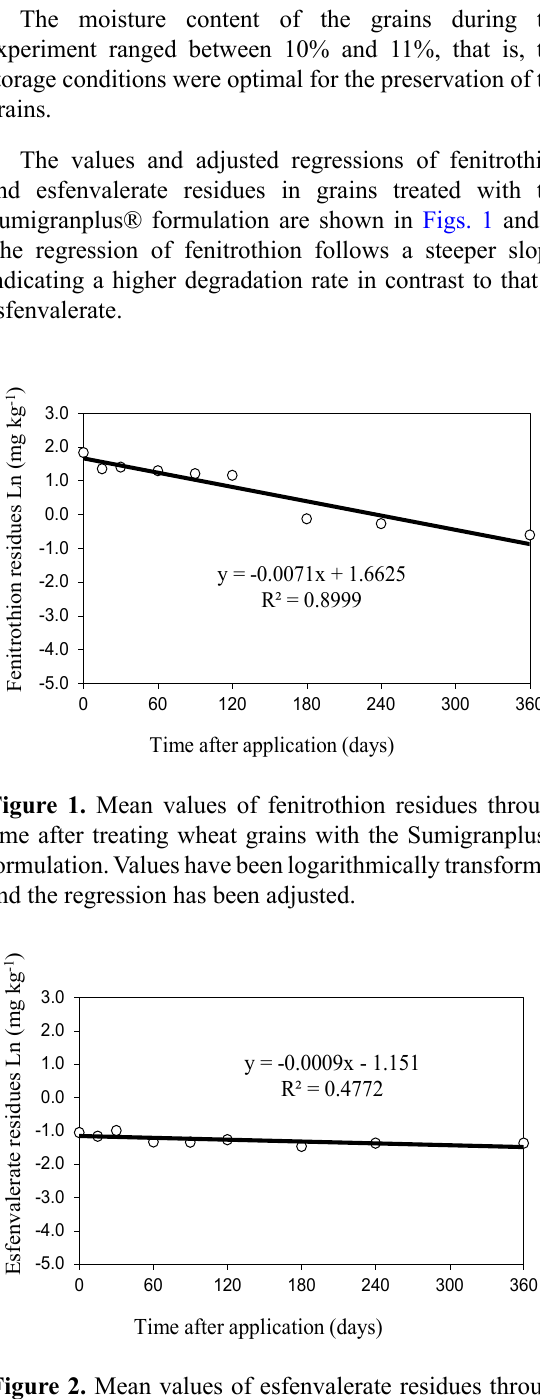
Figure 2. Mean values of esfenvalerate residues through time after treating wheat grains with the Sumigranplus® formulation. The values have been logarithmically transformed and the regression has been adjusted.